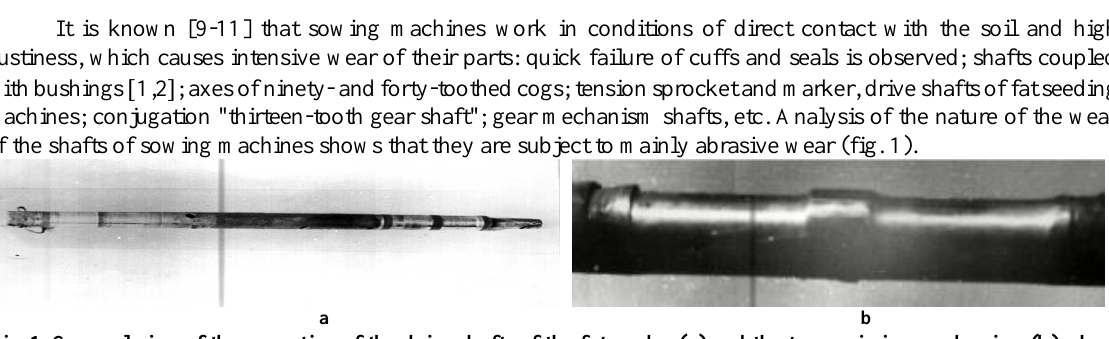
Fig. 1. General view of the operation of the drive shafts of the fat seeder (a) and the transmission mechanism (b) when the CCT-12Б 480 ha seeder is working